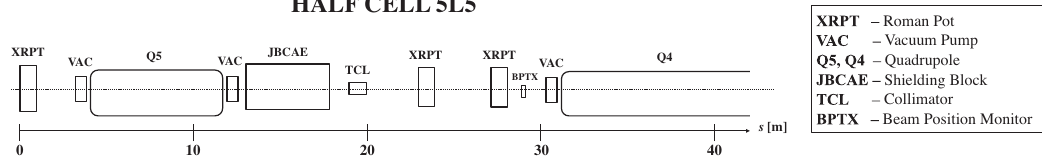
FIG. 3. Schematic diagram of the elements in LSS5. Relative lengths are to